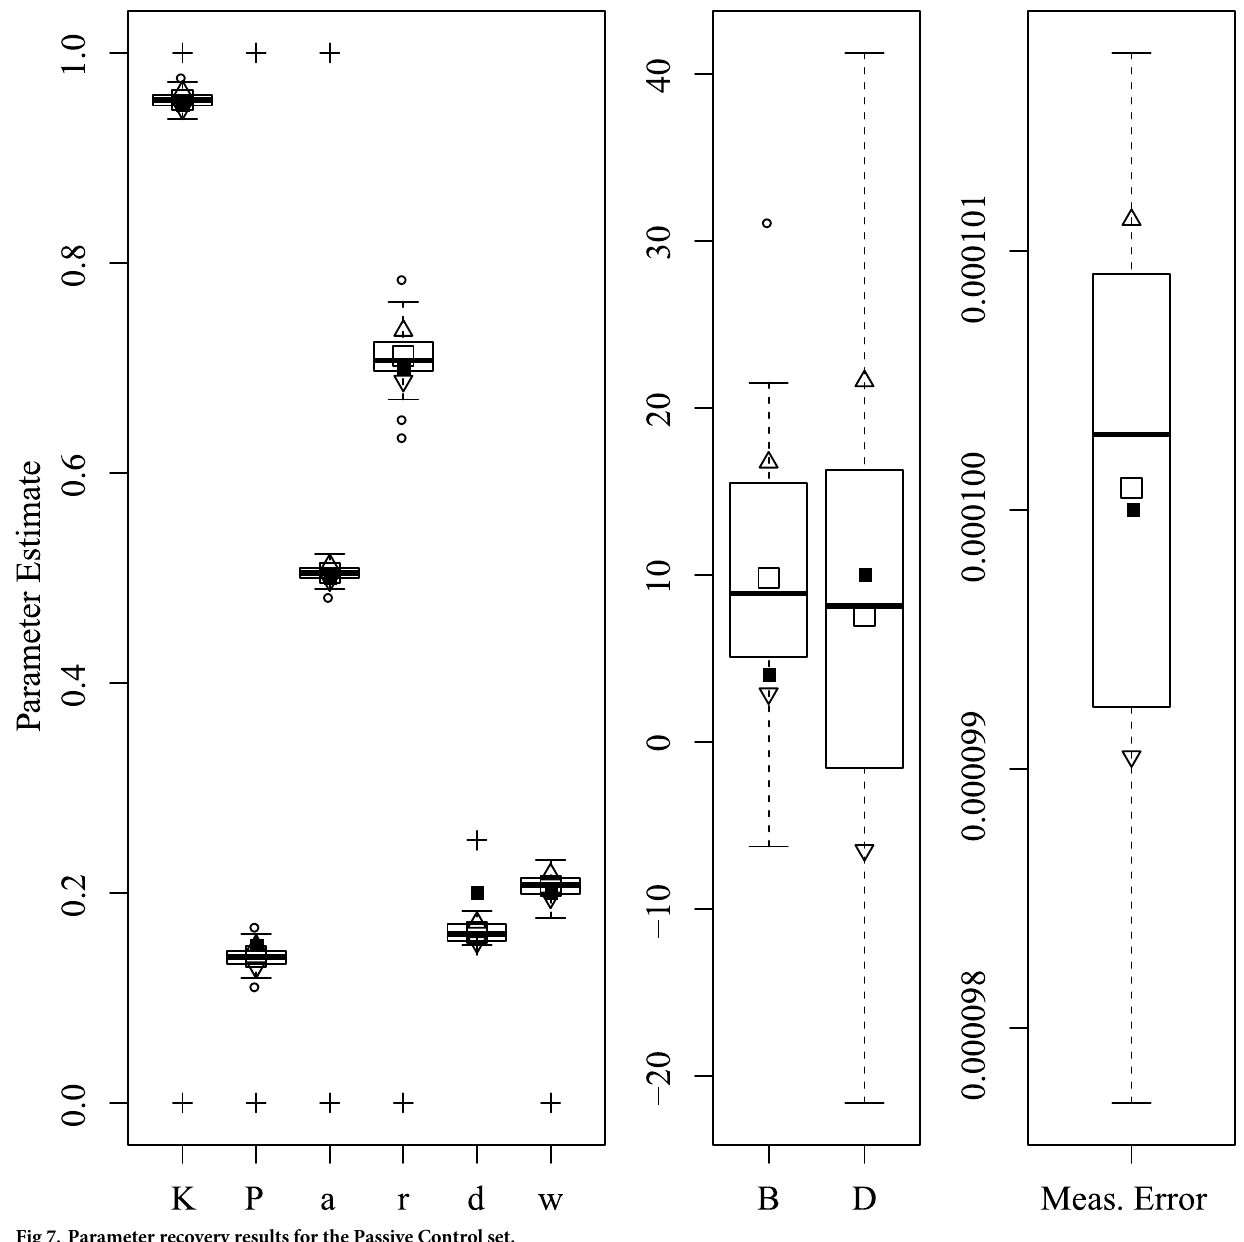
Fig 7. Parameter recovery results for the Passive Control